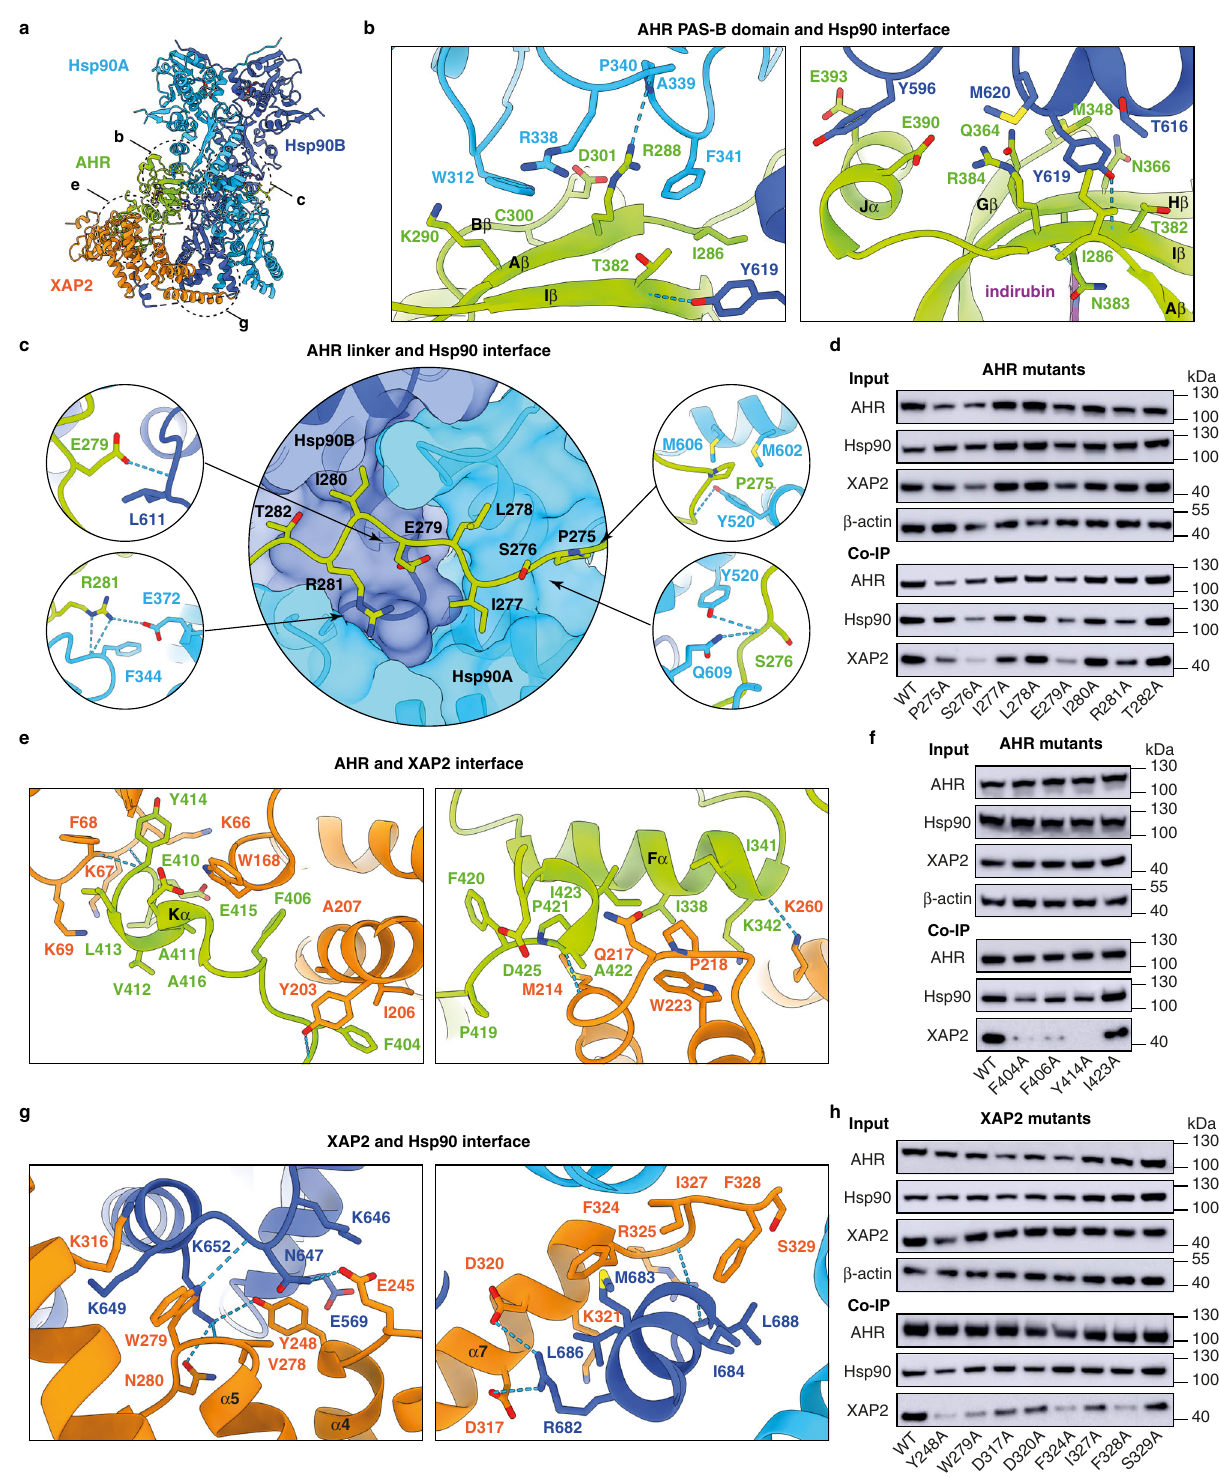
d Resultsof Co-IPforthemutationof theAHRlinker.The datawererepresentative ofthreeindependentexperiments. e Close-upviewoftheinteractionsitesbetween AHR and XAP2. f Co-IP results for the AHR mutants atthe interface with XAP2. The datawererepresentativeoffourindependentexperiments. g Interactionsbetween XAP2andHsp90. h Co-IPresultsfortheXAP2mutantsattheinterfacewithHsp90. The data were representative of two independent experiments. Source data are provided as a Source Data fi